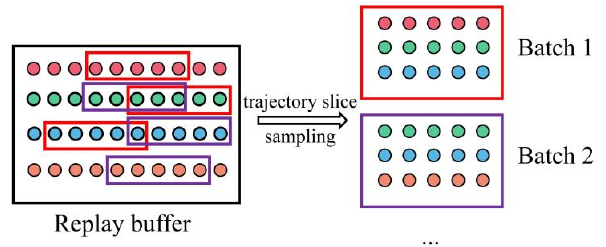
Figure 6. Sampling datasets based on a trajectory slice.